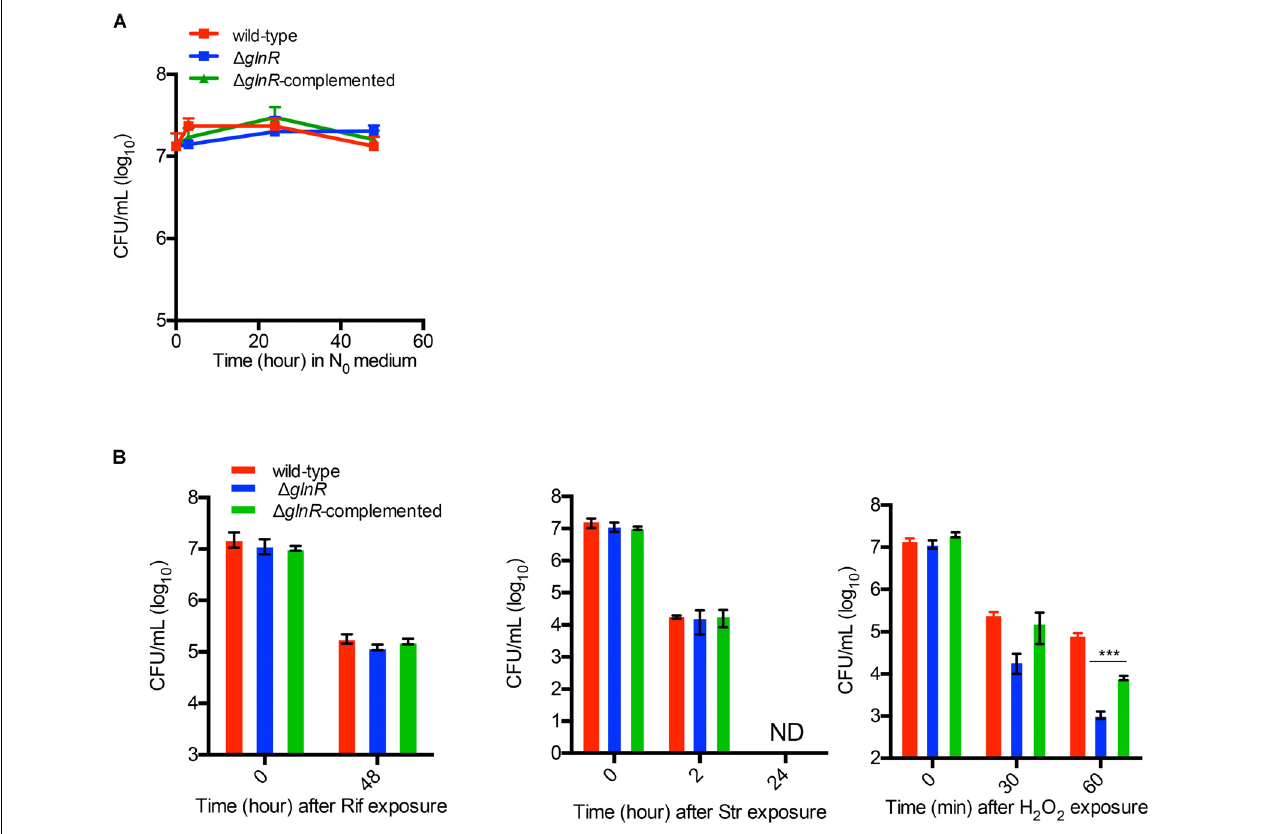
FIGURE 2 | GlnR-dependent resistance of M. smegmatis to hydrogen peroxide under nitrogen-limiting condition. (A) Survival of wild-type, (cid:49) glnR and (cid:49) glnR -complemented strains in nitrogen-free Sauton’s (N 0 ) medium for up to 48 h. Exponentially growing cells (OD 0.3) cultured in Sauton’s medium with 0.05% (v/v) Tween80 were washed and resuspended in N 0 medium for indicated time points prior to plating the dilutions on 7H10ADC plate. (B) Effect of streptomycin (Str; 1 µ g/mL), rifampicin (Rif; 400 µ g/mL), and hydrogen peroxide (H 2 O 2 ; 20 mM) on survival of wild-type, (cid:49) glnR and (cid:49) glnR -complemented strains in N 0 medium. Cells were incubated in N 0 medium for 6 h prior to exposure to each condition for the indicated period of time. Data are representative of mean of three biologically independent experiments. ∗∗∗ indicates p ( t -test) < 0.001.